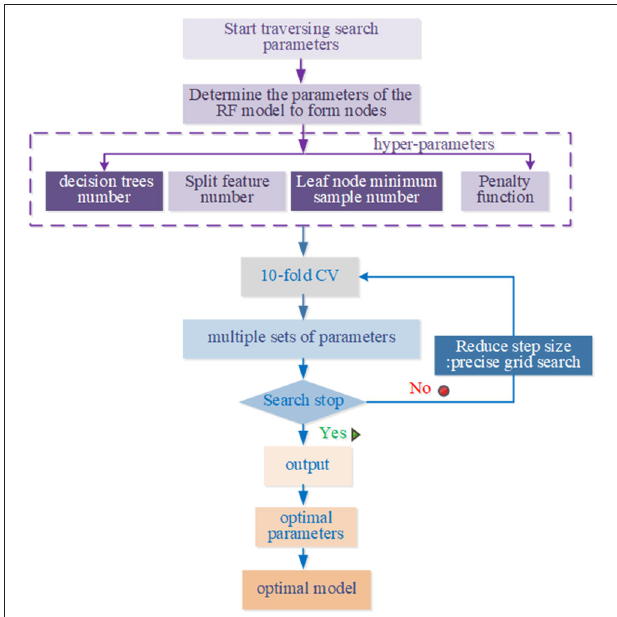
FIGURE 3 | Parameters optimization flow to GSO.